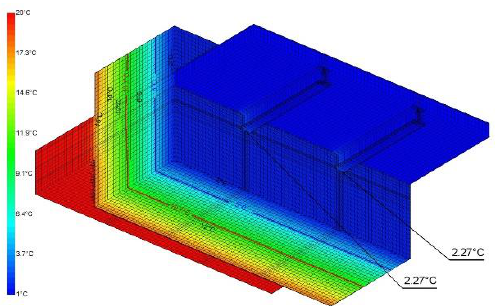
Figure 17. External surface temperature distribution field on the wall and balcony slab—bottom view.